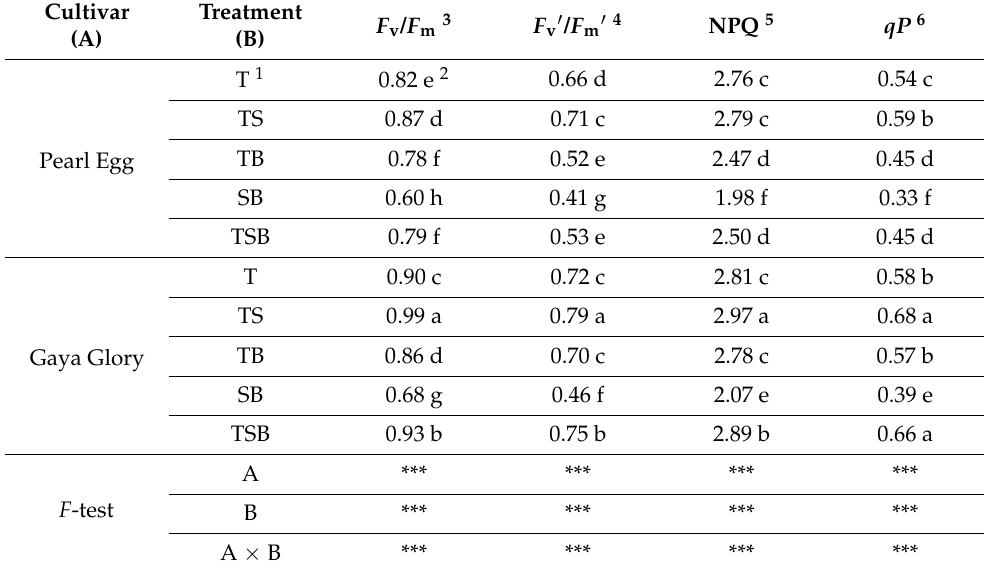
Table 3. Influence of the lighting direction combination on the chlorophyll fluorescence characteristics of chrysanthemums grown for 45